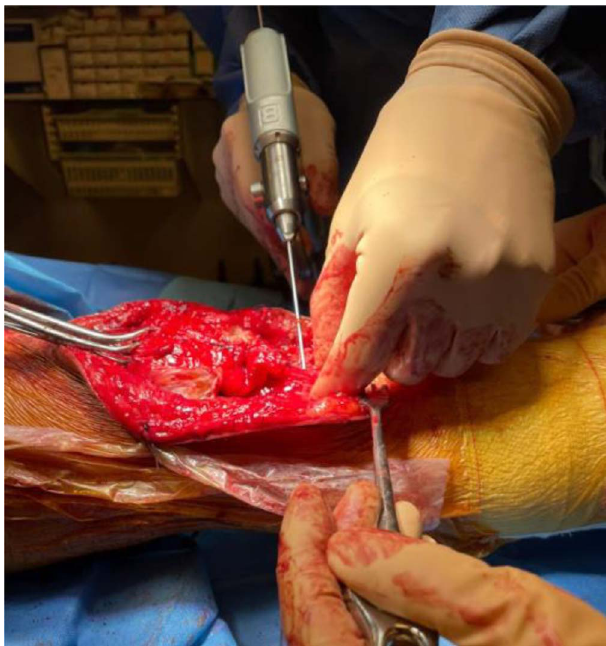
Figure 8. 2.8 mm guidewire is inserted transversely through the distal 1/3 of the anterior tibial tuberosity.